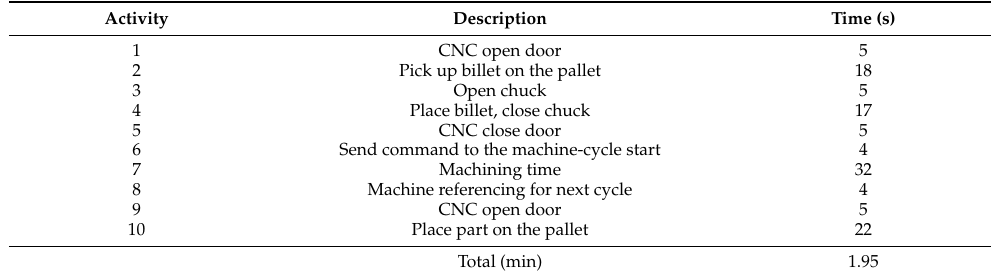
Table 2. Operation times of the real FMS to compare with DT simulated times (average of five turned